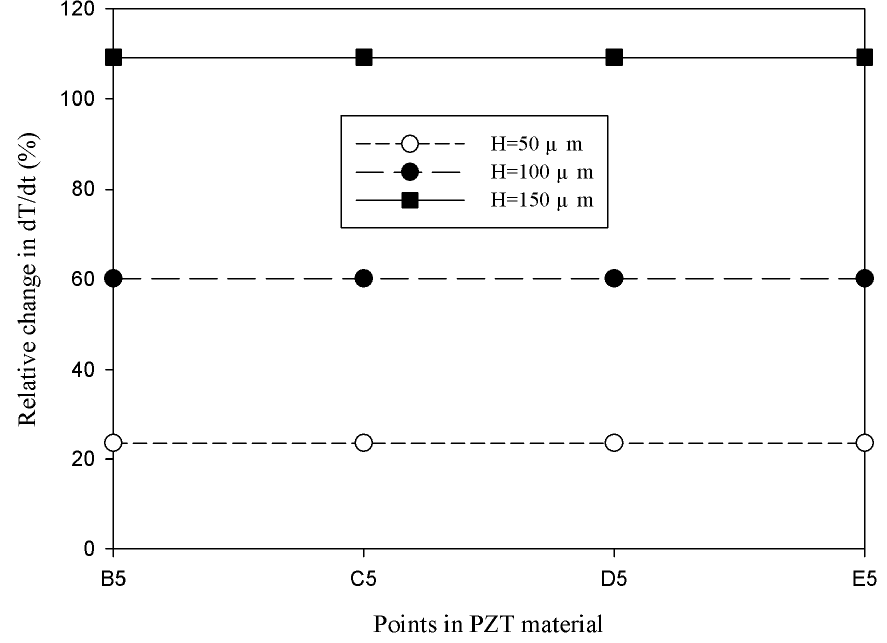
Figure 14. Simulated relative change in the maximum peak value of the temperature variation rate at points B5, C5, D5 and E5 for the mesh top electrode with cavities in the PZT material, compared with that at point A5 for the fully covered electrode, with an electrode width of 200 μ m and etching depths of 50, 100 and 150 μ